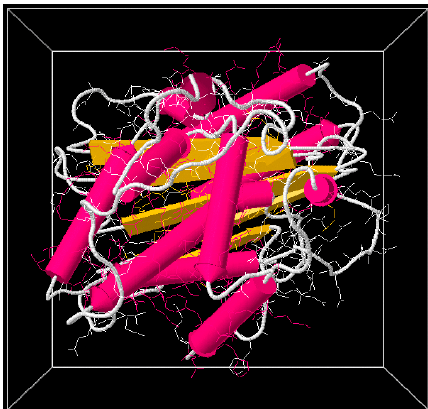
Figure 7. The illustration of the beta-lactamase section of the pBR322plasmid DNA.